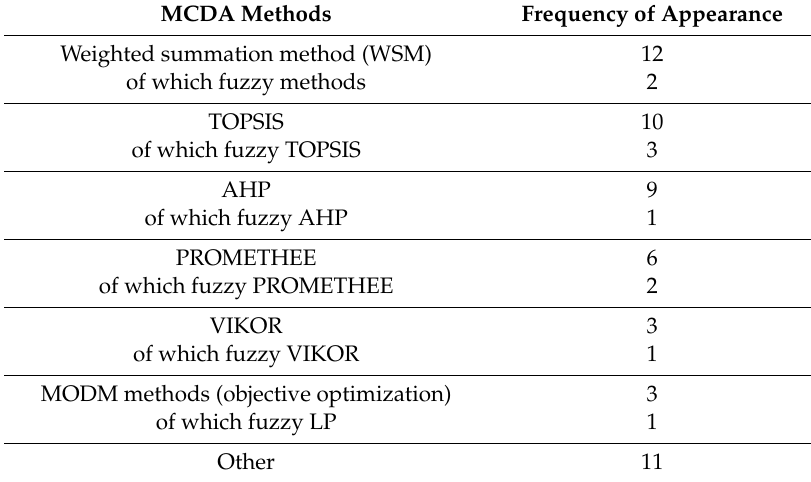
Table 5. MCDA methods of reviewed papers: frequency of appearance (more than one method possible per